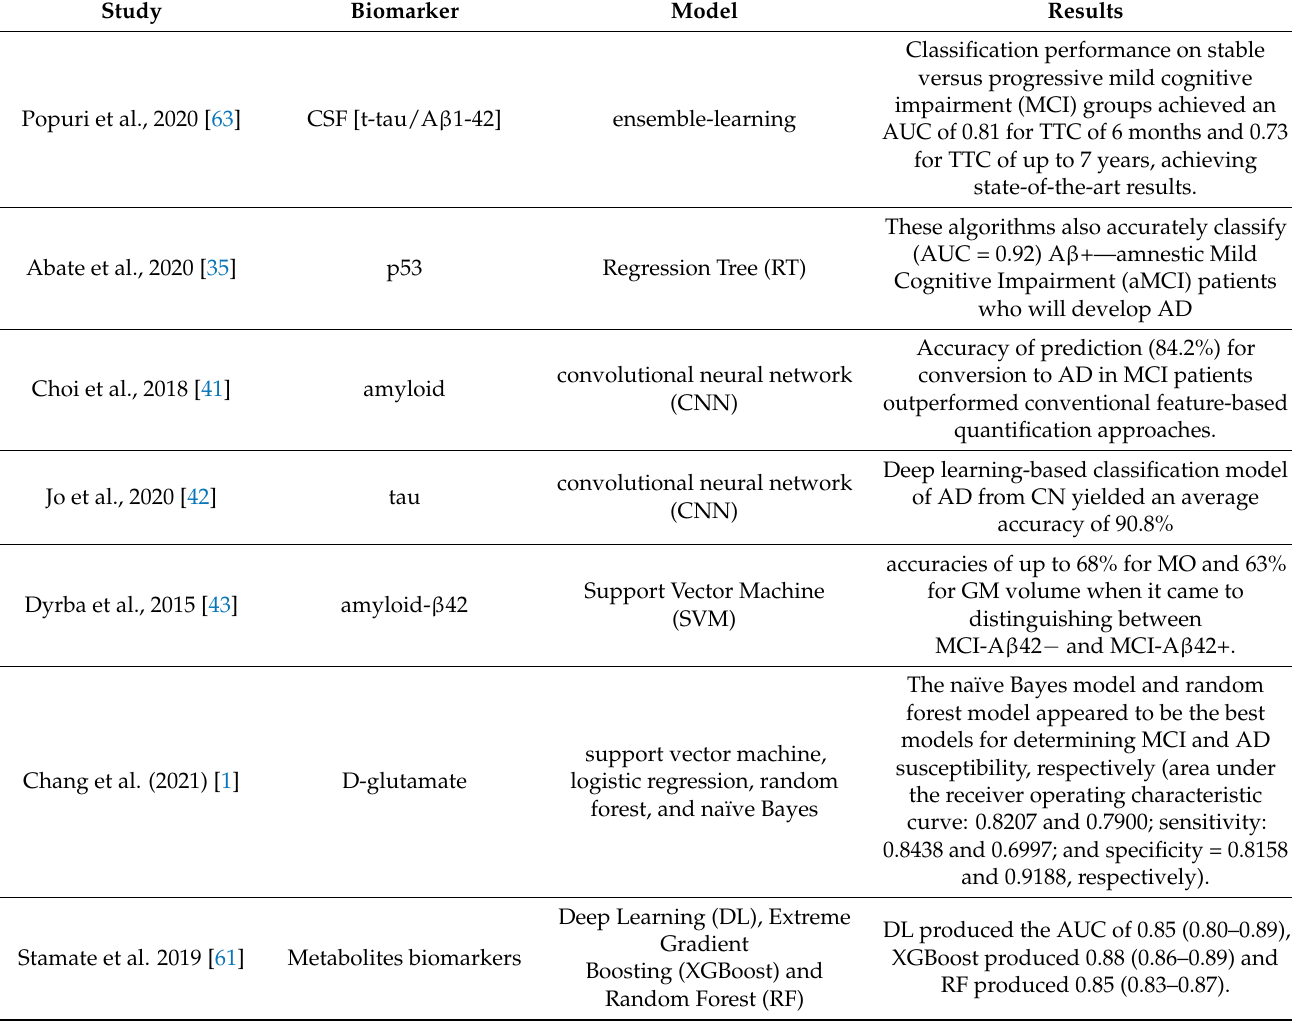
Table 2. Relevant studies on the biomarkers and predictive models of